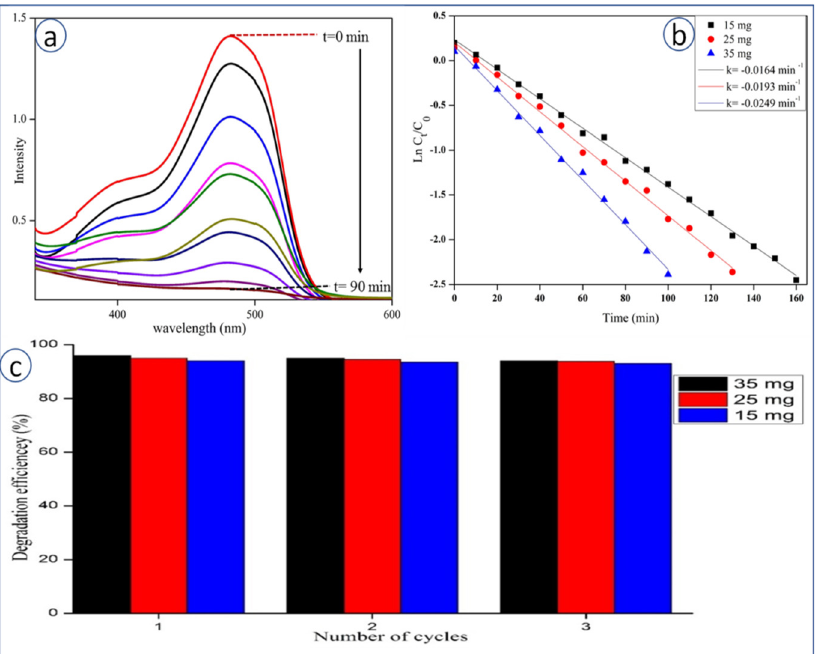
Figure 6. ( a ) UV-Visible absorbance spectra of SY dye during degradation with CeO 2 NPs, ( b ) kinetic Figure 6. (a) UV-Visible absorbance spectra of SY dye during degradation with CeO 2 NPs, (b) kinetic studies of SY dye degradation with CeO 2 NPs, ( c ) recyclability study of di ff erent amounts of catalysts studies of SY dye degradation with CeO 2 NPs, (c) recyclability study of different amounts of catalysts recovered towards degradation of SY recovered towards degradation of SY Dye.